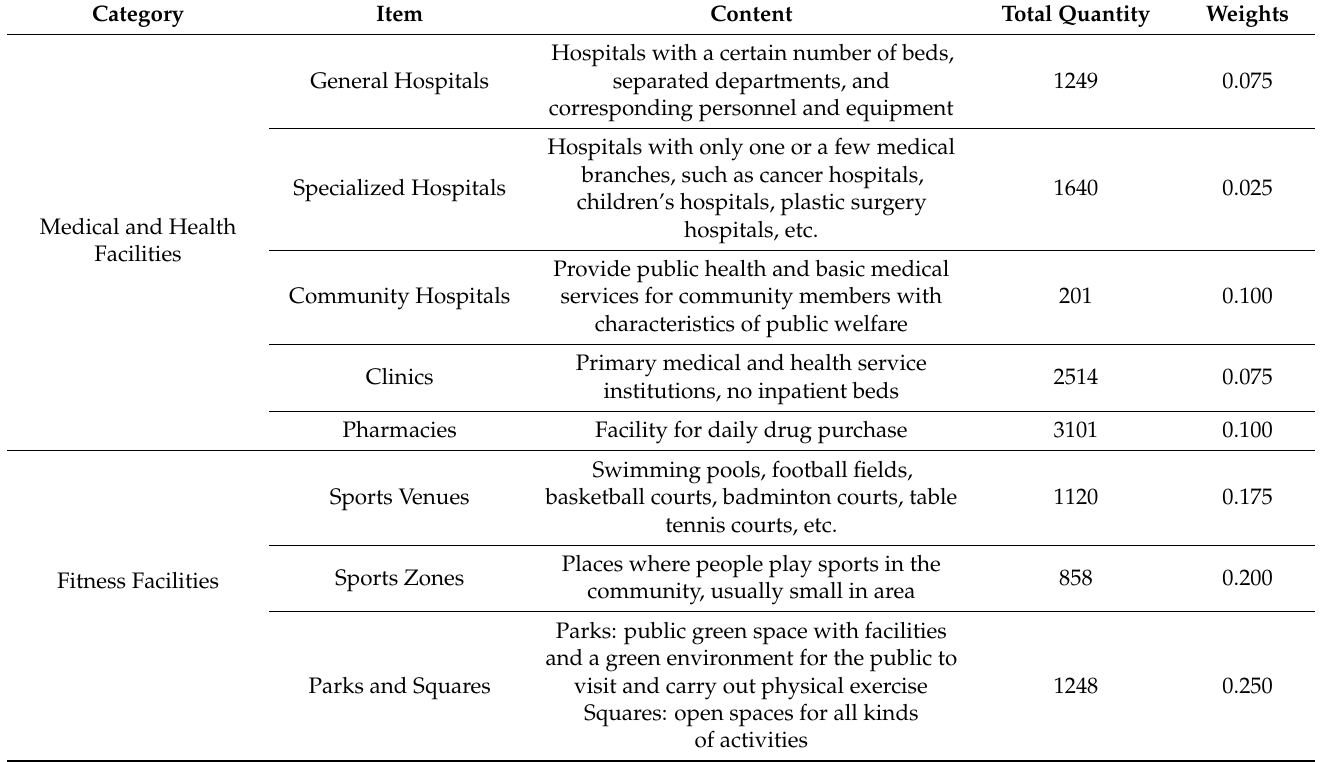
Table 1. Classification and weighting of health service facilities in healthy community-life